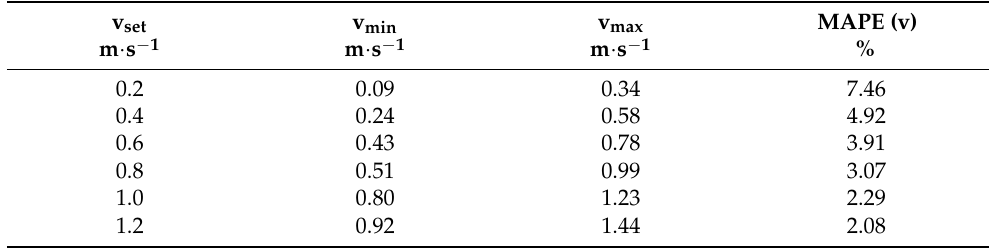
Table 2. Air velocity (v meas ) in drying column with empty sample trays at different v set in the HPD TF3+; min, max and MAPE values after a start-up phase of 50